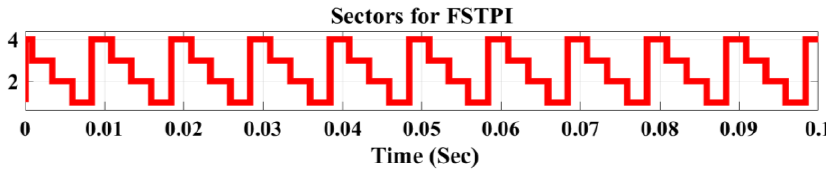
Figure 17. Sectors of pulse width modulated voltage of FSTPI